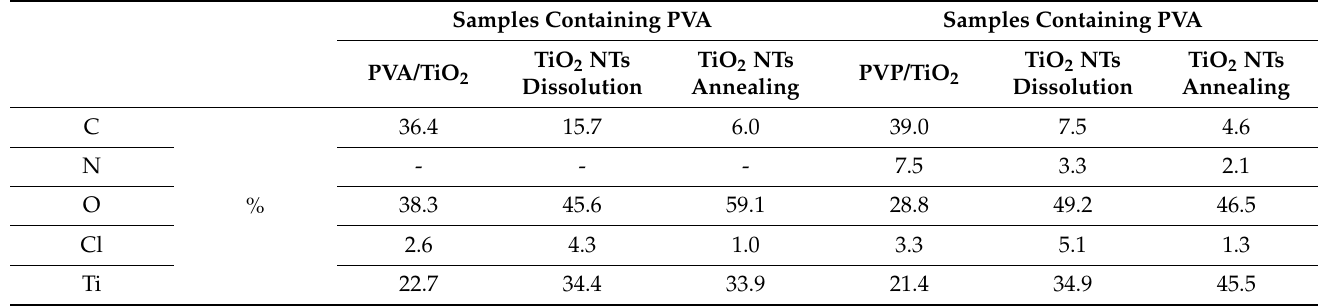
Table 1. EDX results of the